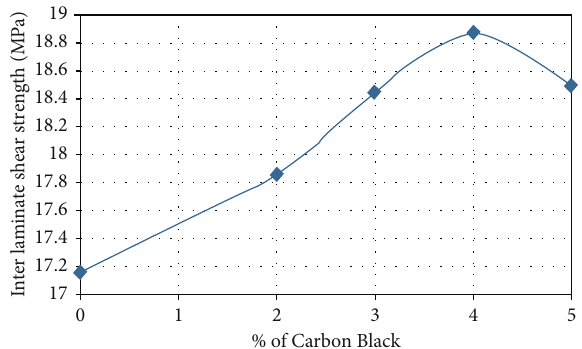
Figure 7: Effect of carbon black on interlaminar shear strength of the vinyl ester composites.